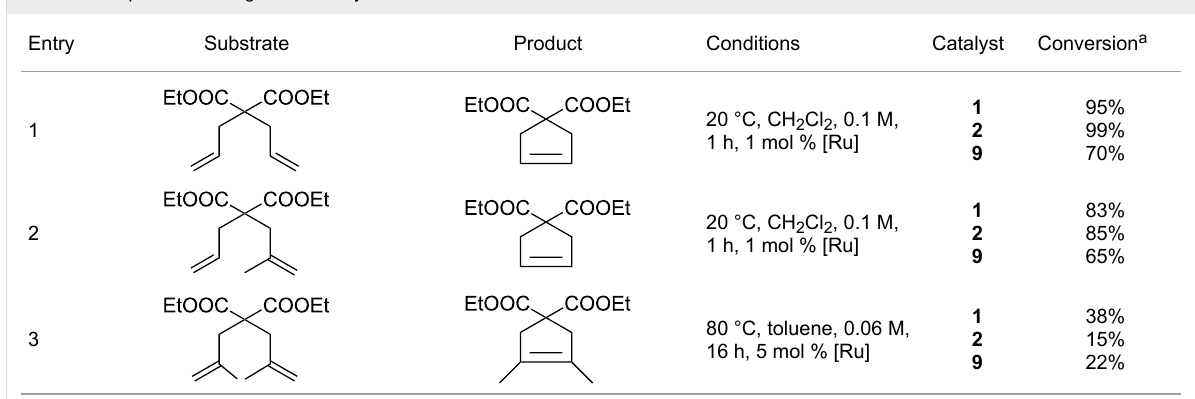
Table 3: Comparative investigation of catalysts in RCM. Entry Substrate Product